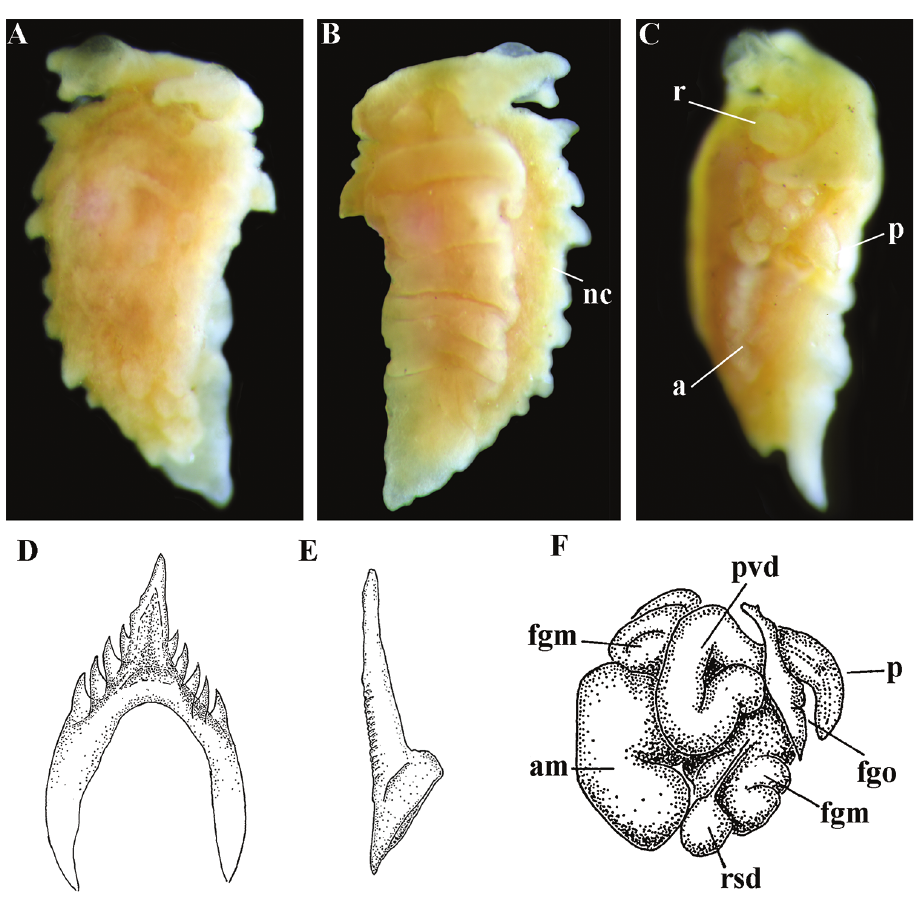
Figure. 10. Paracoryphella parva (Hadfield, 1963), comb. n. Holotype NHMD-91476, 2 mm length: A fixed animal, dorsal view B fixed animal, ventral view of anterior part C fixed animal, lateral view D ra- chidian radular teeth E lateral teeth F reproductive system. Abbreviations: a anus am ampulla fgm female gland mass fgo female genital opening nc continuous notal edge p penis pvd prostatic vas deferens r rhinophores rsd distal receptaculum seminis. Photos by A.V. Martynov. Drawings D, E, F from original description of P. parva from Hadfield